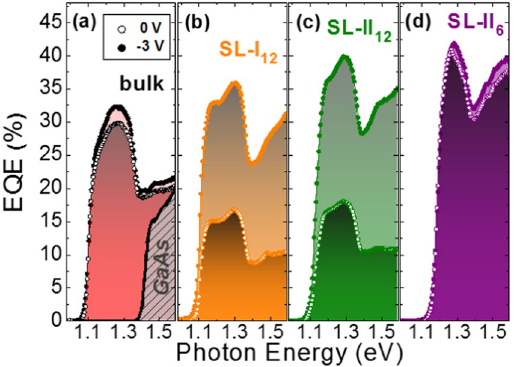
Figure 5. External quantum efficiency of the solar cell devices. EQE spectra measured at room temperature at 0 V (empty dots) and with a reverse bias voltage of − 3 V (filled dots) from samples ( a ) bulk together with sample GaAs as a reference ( b ) SL-I 12 ( c ) SL-II 12 and ( d ) SL-II 6 . The spectra of samples bulk and GaAs have been normalized to account for the fact that they have double amount of active material (low bandgap